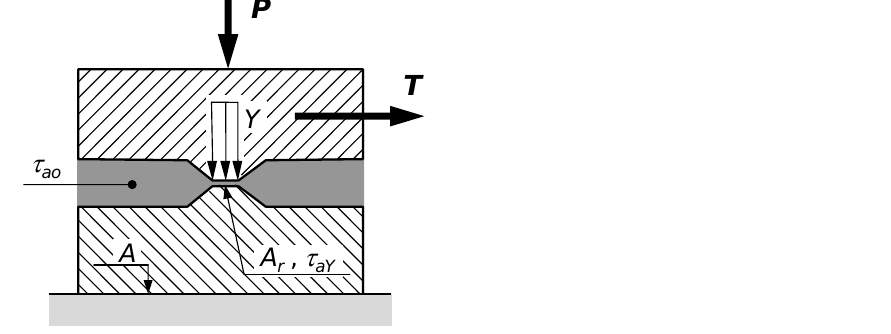
Figure 2. Schematic representation of the hybrid interface according to the micromechanical model.